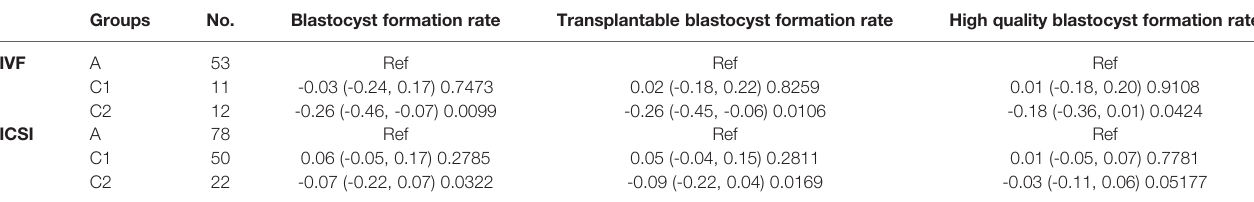
The data in the table: effect size (95% CI) p